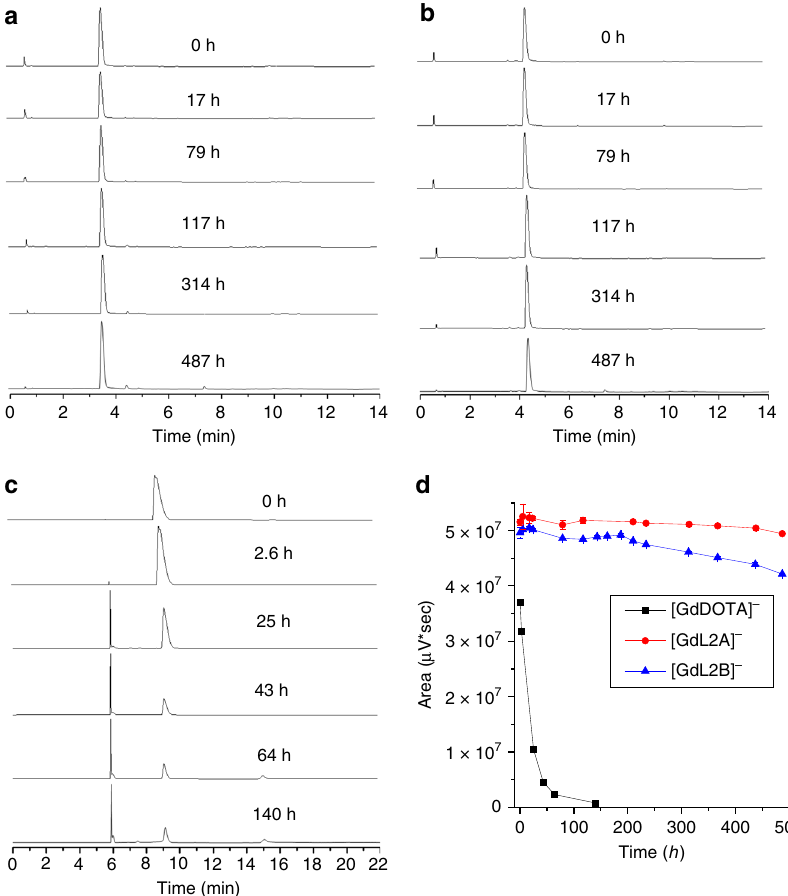
Fig. 5 Stability of Gd complexes. a – c RP-HPLC traces of [GdL2A] − , [GdL2B] − and [GdDOTA] − in 1N HCl at room temperature over time. d Change in peak area integration over time. Quantitative analysis with RP-HPLC suggest [GdL2A] − and [GdL2B] − exhibit much higher stability than [GdDOTA] − in acidic medium at room temperature. Error bars for [GdL2A] - and [GdL2B] - refer to the standard error of mean (S.E.M.), statistical data fi tting analysis (n = 3;